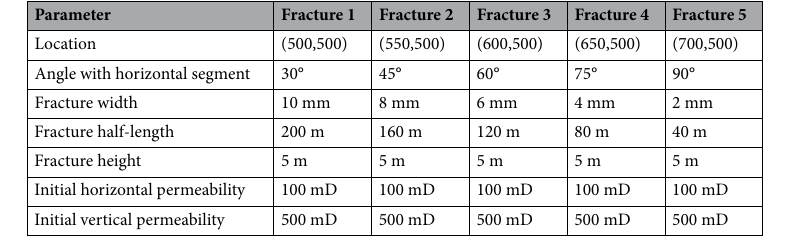
Table 2. List of fracture parameters.